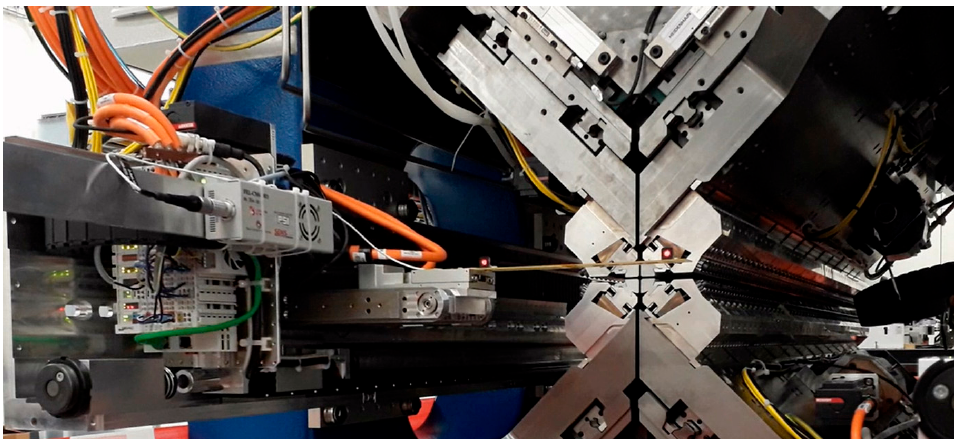
Figure 8. AppleX undulator prototype at Paul Scherrer Institute (PSI) facilities used for initial performance testing of the instrument.